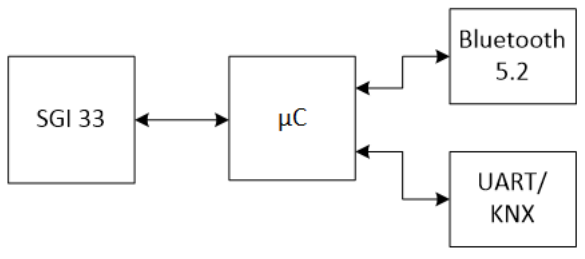
Figure 4. Block scheme of communication.